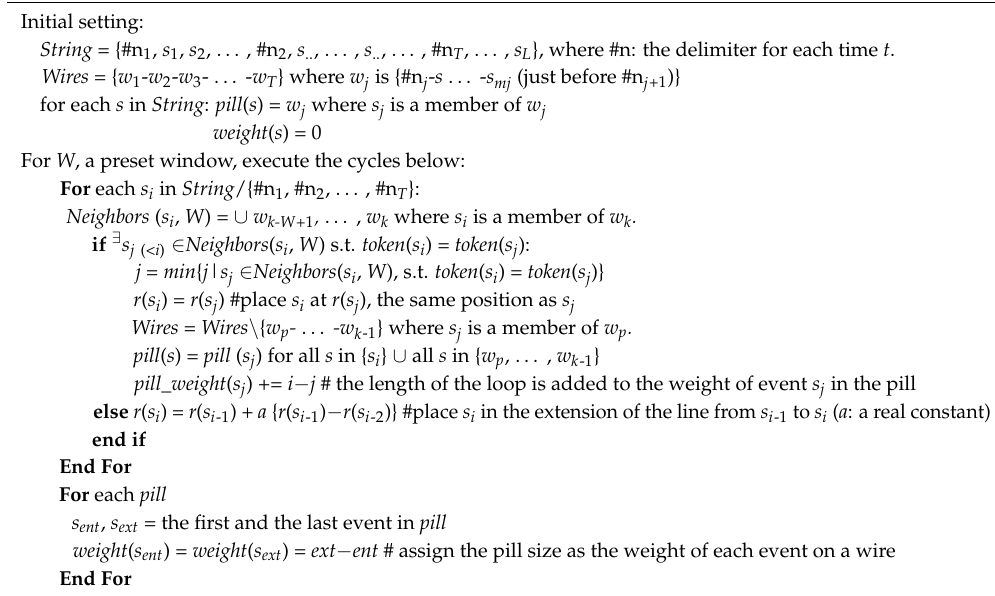
Algorithm 2. An extension of TS for dealing with basket data; TS for basket-set